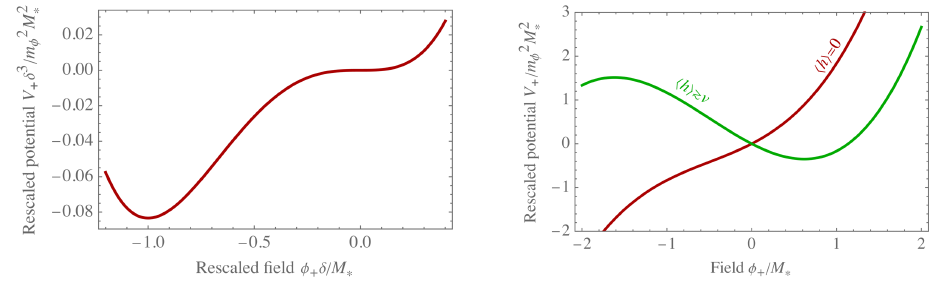
Figure 5 . Example potential V − ( φ − ) with two widely separated minima. The right panel zooms in close to the safe local minimum at φ ∼ M ∗ . This is destabilised if the Higgs acquires a large vev (red line). Note the different rescaling in the two panels for both the field and the potential.